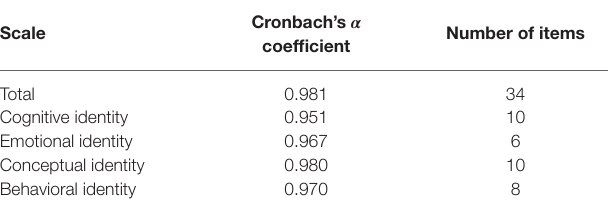
TABLE 4 | Reliability test.